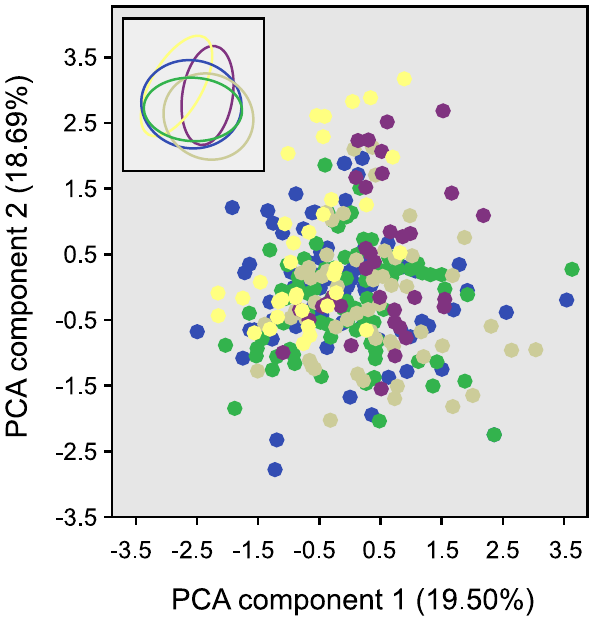
Figure 1. Comparison of MTS diversity among five taxa using multivariate PCA. The first two components are plotted, which represent 38.19% of variation among MTS sequences. Insert depicts simplified version of the scatterplot to emphasise boundaries of distribution. Blue – H. sapiens , Green – M. musculus , Beige – S. cerevisiae , Purple – A. thaliana , Yellow – O. sativa .